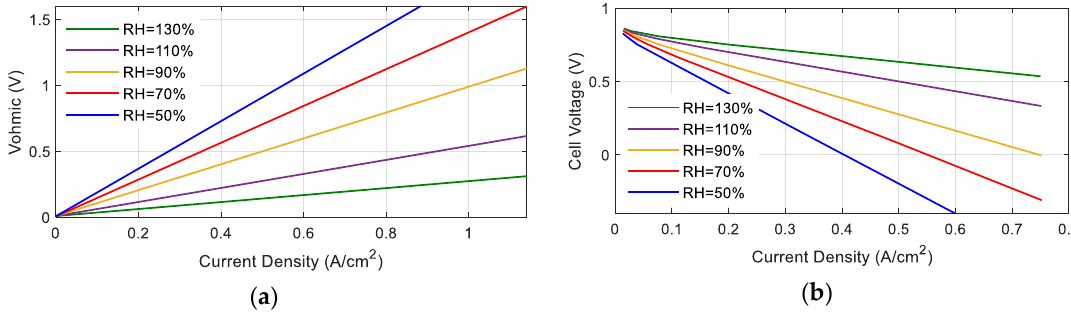
Figure 9. Effect of relative humidity on ( a ) Ohmic losses, and ( b ) Cell voltage loss. Figure 9. E ff ect of relative humidity on ( a ) Ohmic losses, and ( b ) Cell voltage